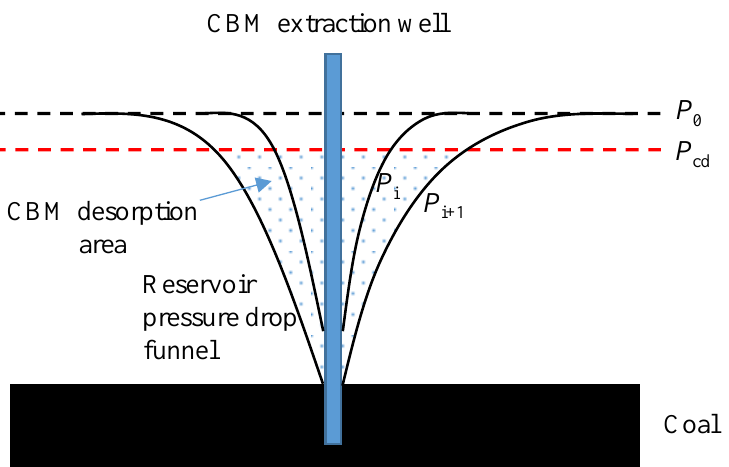
Figure 2. CBM reservoir pressure drop propagation schematic. P 0 —Original reservoir pressure; P cd —Critical desorption pressure; P i —Reservoir pressure with extraction time i.